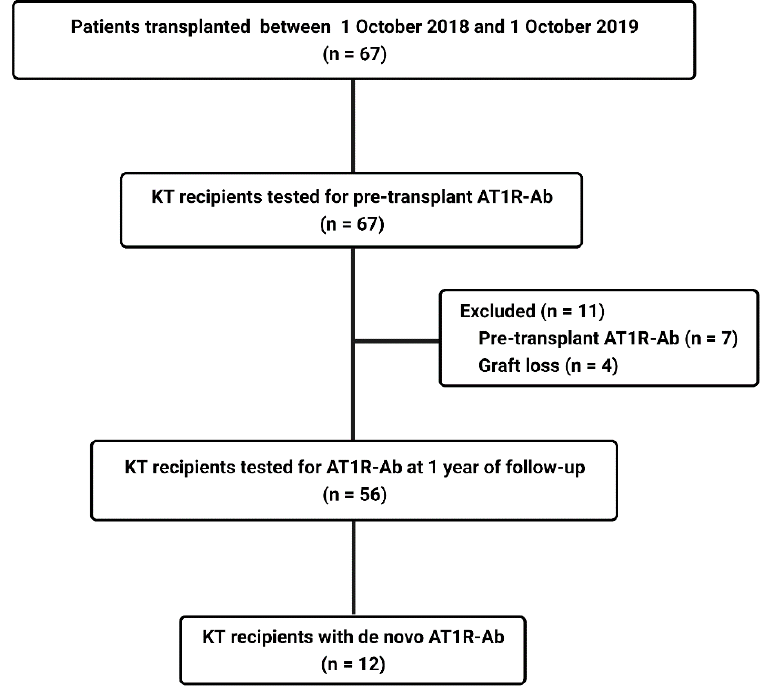
Figure 1. Study flow diagram.